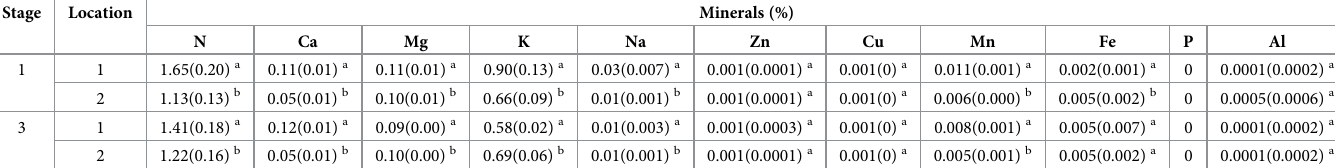
Table 4. Comparison of the mineral composition of S . madagascariensis seeds collected from different locations at two stages of ripeness. The means for each parameter are reported under the respective stages of maturity followed by the standard error. Means accompanied by the same letter in a given column are not signifi- cantly different (P > 0.05). Location 1: Bushbuckridge, Location 2: Shongweni Nature